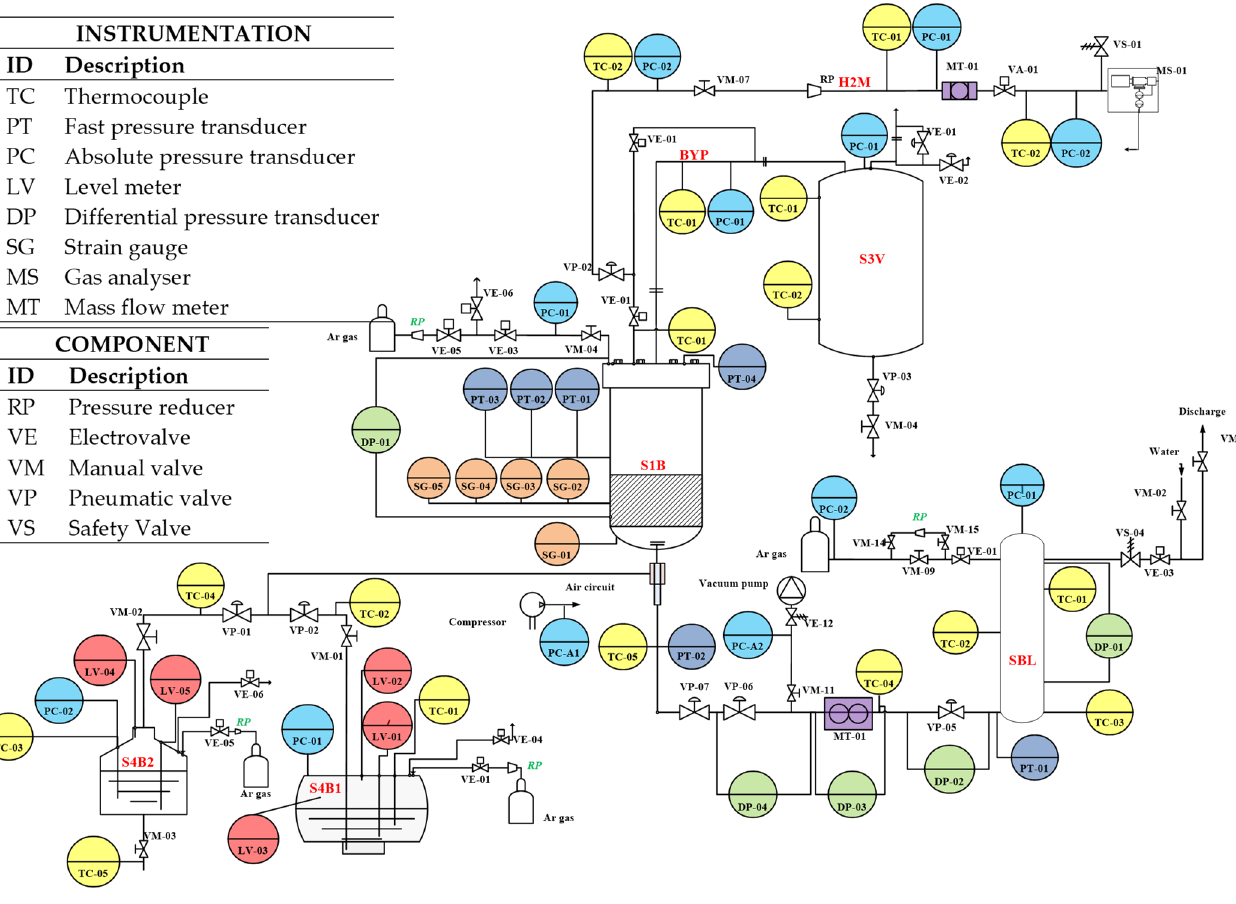
Figure 1. LIFUS5/Mod3 Process and Instrumentation diagram.